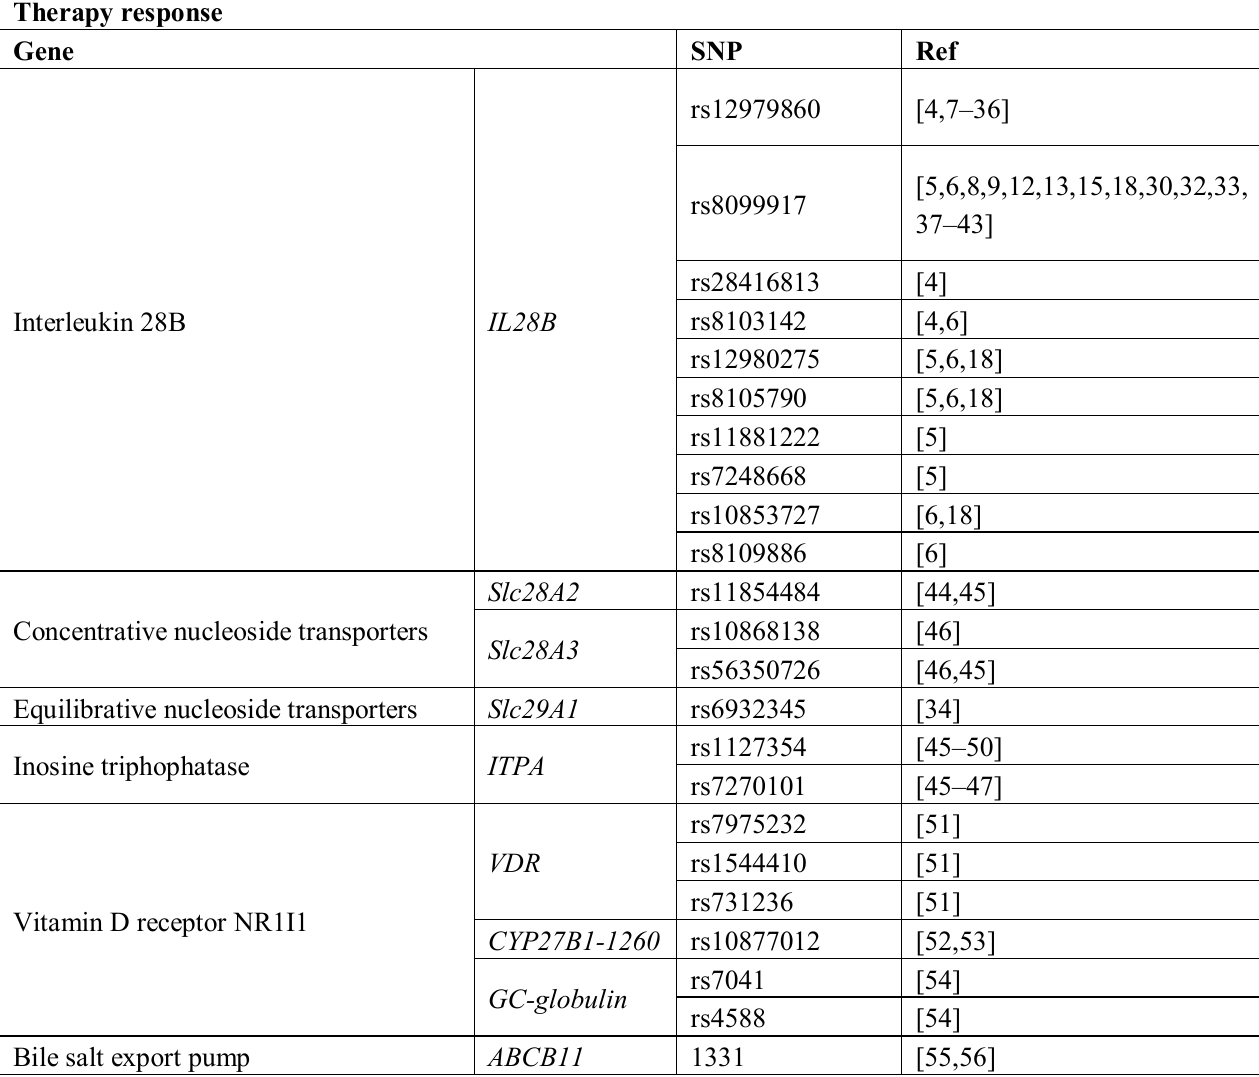
Table 1. Host genetics associated with therapy